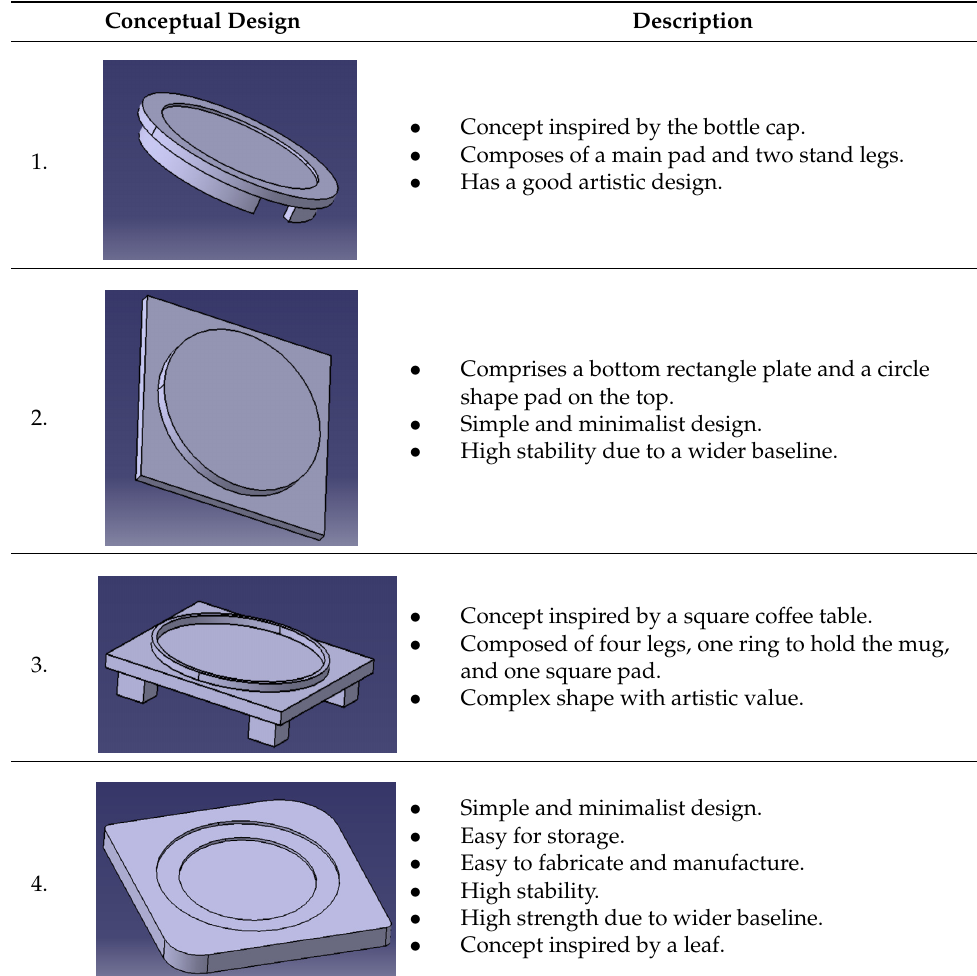
Table 6. Proposed conceptual designs of a roselle fiber biocomposite mug pad [111] .